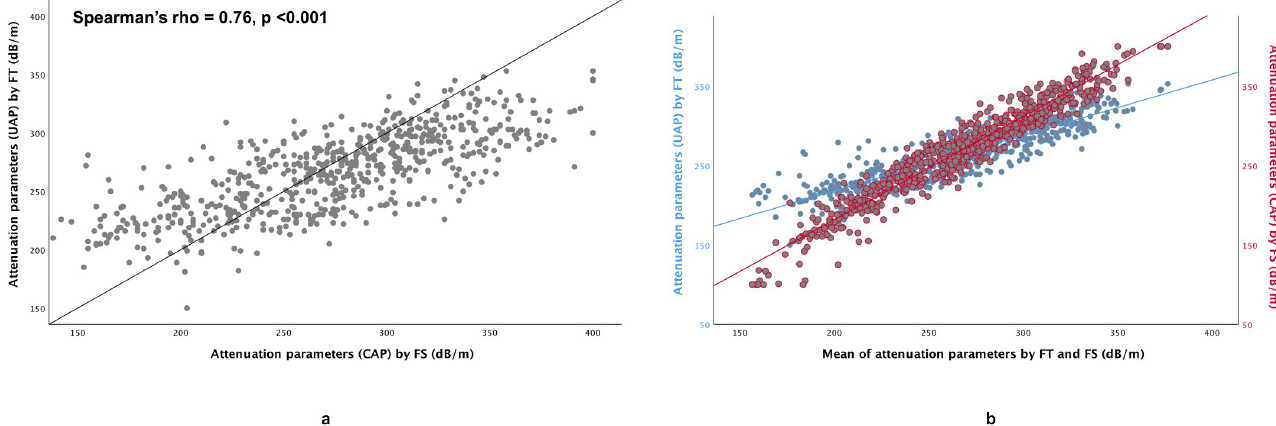
Fig 1. Scatter plots for ( a ) attenuation parameters obtained using FibroTouch (FT) vs Fibroscan (FS), and ( b ) attenuation parameters obtained using FT and FS vs mean of attenuation parameters obtained using FT and FS. https://doi.org/10.1371/journal.pone.0250300.g001 obtained using FT and FS were significantly different overall, being higher at lower LSM and lower at higher LSM ( Table 2 ). The IQR/median for LSM obtained using FT was significantly lower compared with the IQR/median for LSM obtained using FS ( Table 2 ). Bland–Altman analysis for LSM revealed a mean difference of 0.91 kPa between liver stiffness measurement Table 2. Comparison of attenuation parameter and liver stiffness measurement obtained using FibroTouch and Fibroscan. FibroTouch